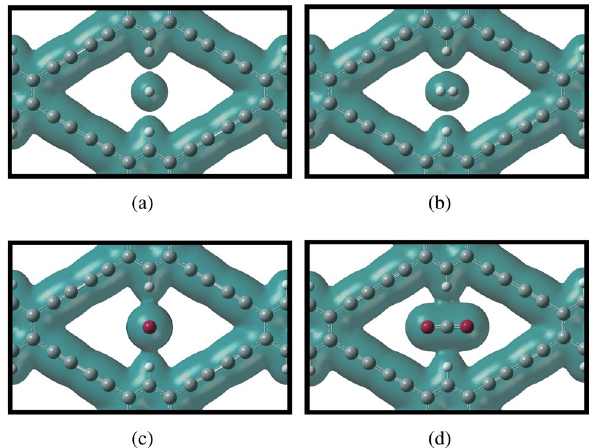
Figure 4. Electron density isosurfaces for H 2 and CO 2 gas molecules passing horizontally ( a , c ) and vertically ( b , d ) through GDY-H membrane, respectively. The isovalue is 0.0065 eÅ − 3 .